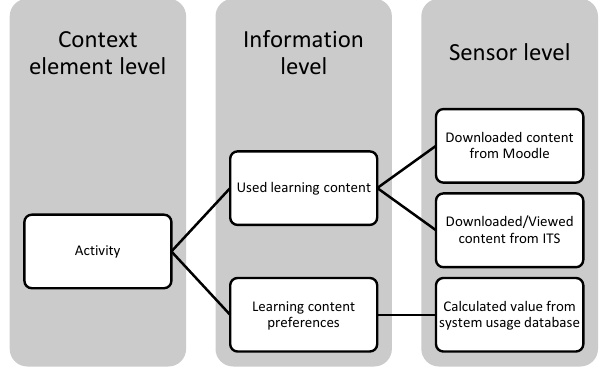
Fig. 3. Context element model structure example.